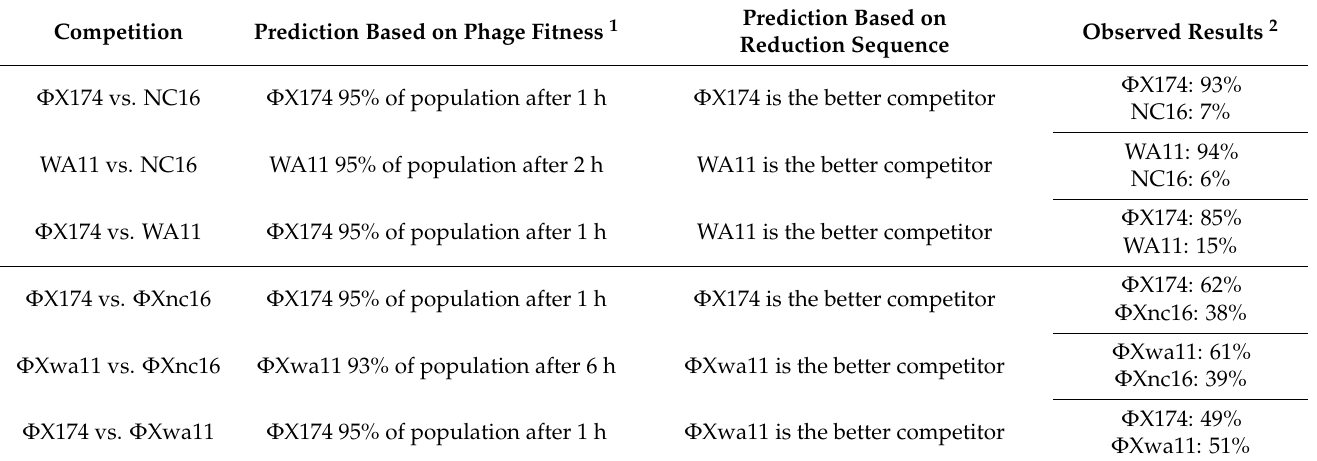
Table 3. Predicted and observed outcomes of phage–phage